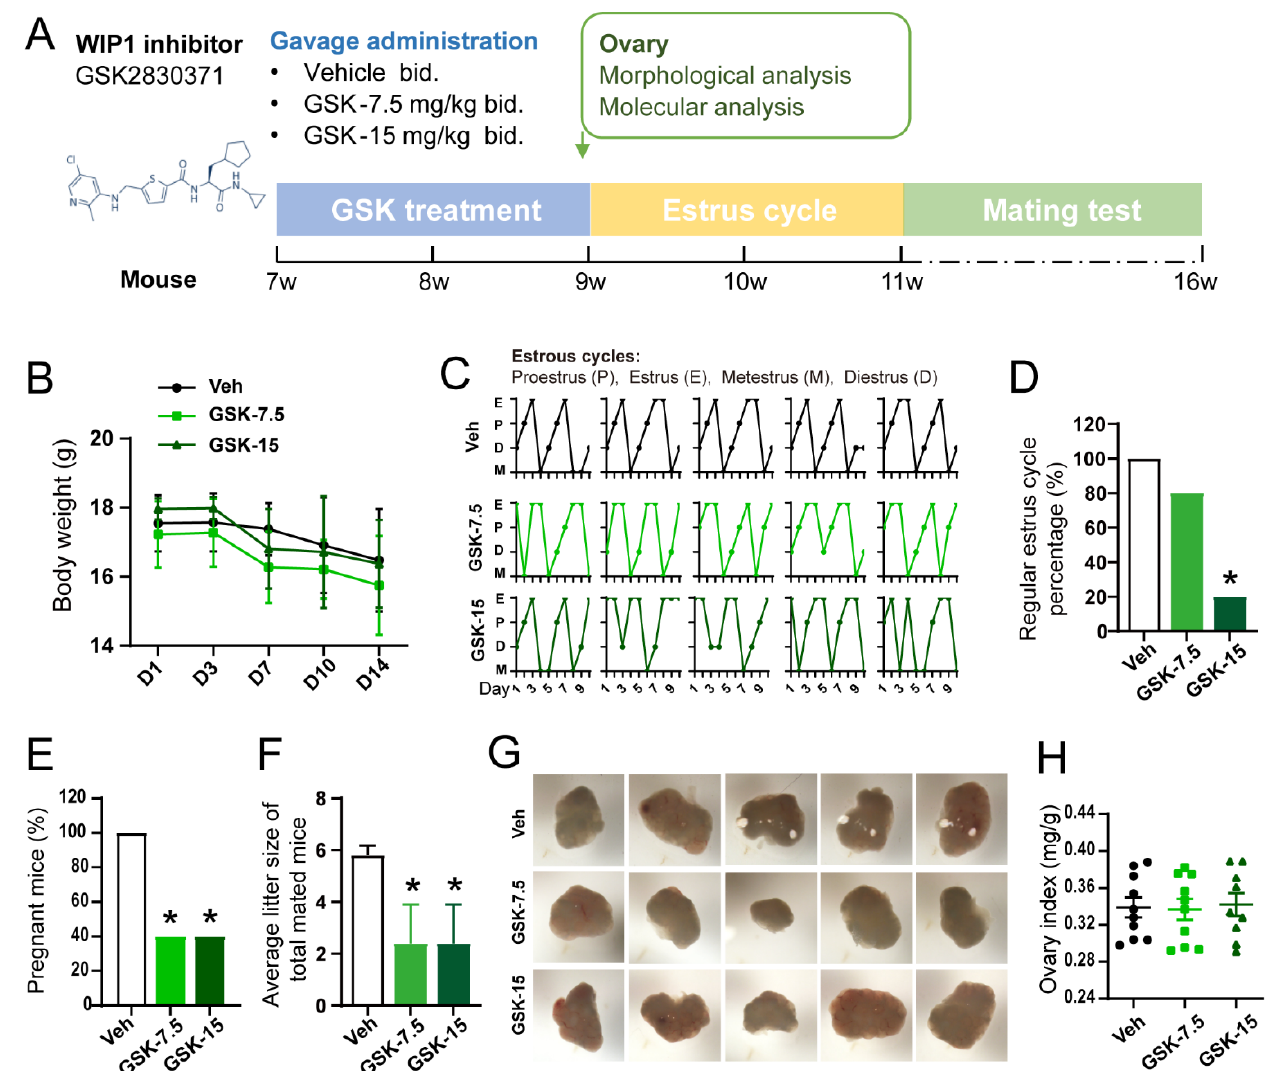
Figure 2. The effect of WIP1 inhibitor treatment on reproductive ability and estrous cycles. ( A ) Schematic diagram of the animal experiment. ( B ) Body weight during the gavage administration ( n = 12, one-way ANOVA). ( C ) Representative estrous cycles of mice from Veh group, GSK-7.5 group and GSK-15 group. ( D ) The proportion of regular estrous cycles ( n = 10, Fisher’s exact test). ( E ) The proportion of pregnant mice of total mated mice ( n = 10, Fisher’s exact test). ( F ) Average litter size of total mated mice ( p < 0.05, one-way ANOVA). ( G ) Representative ovary images. ( H ) Ovary index (ovary weight/body weight) ( n = 10, one-way ANOVA). Black circle: Veh group; light green square: GSK-7.5 group; dark green triangle: GSK-15 group. Data are presented as the mean ± SD. * compared with the Veh group. * p < 0.05.